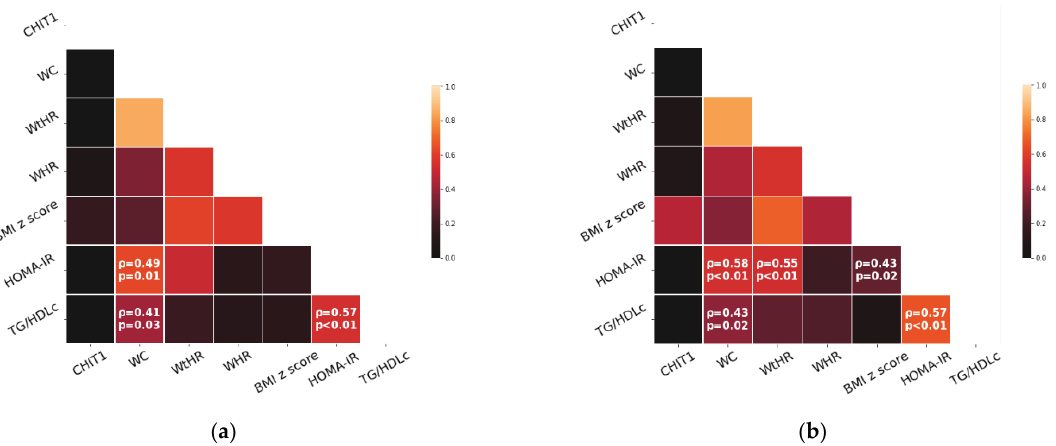
Figure 2. Cross-sectional associations between surrogate indexes of IR and indicators of adiposity: ( a ) at baseline and ( b ) at follow-up. The Spearman’s rank correlation coefficients ( (cid:36) ) are displayed only in case of significant correlations ( p <